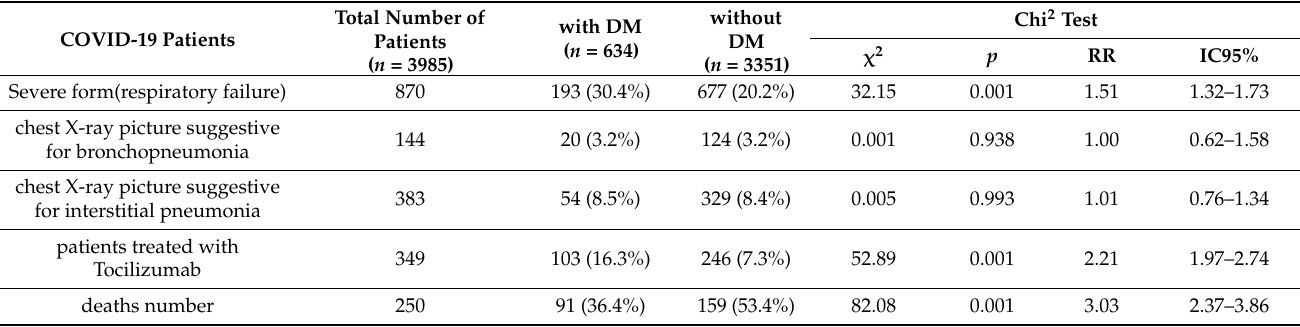
Table 6. Clinical evolution characteristics of diabetic vs. non-diabetic COVID-19 patients. COVID-19 Patients